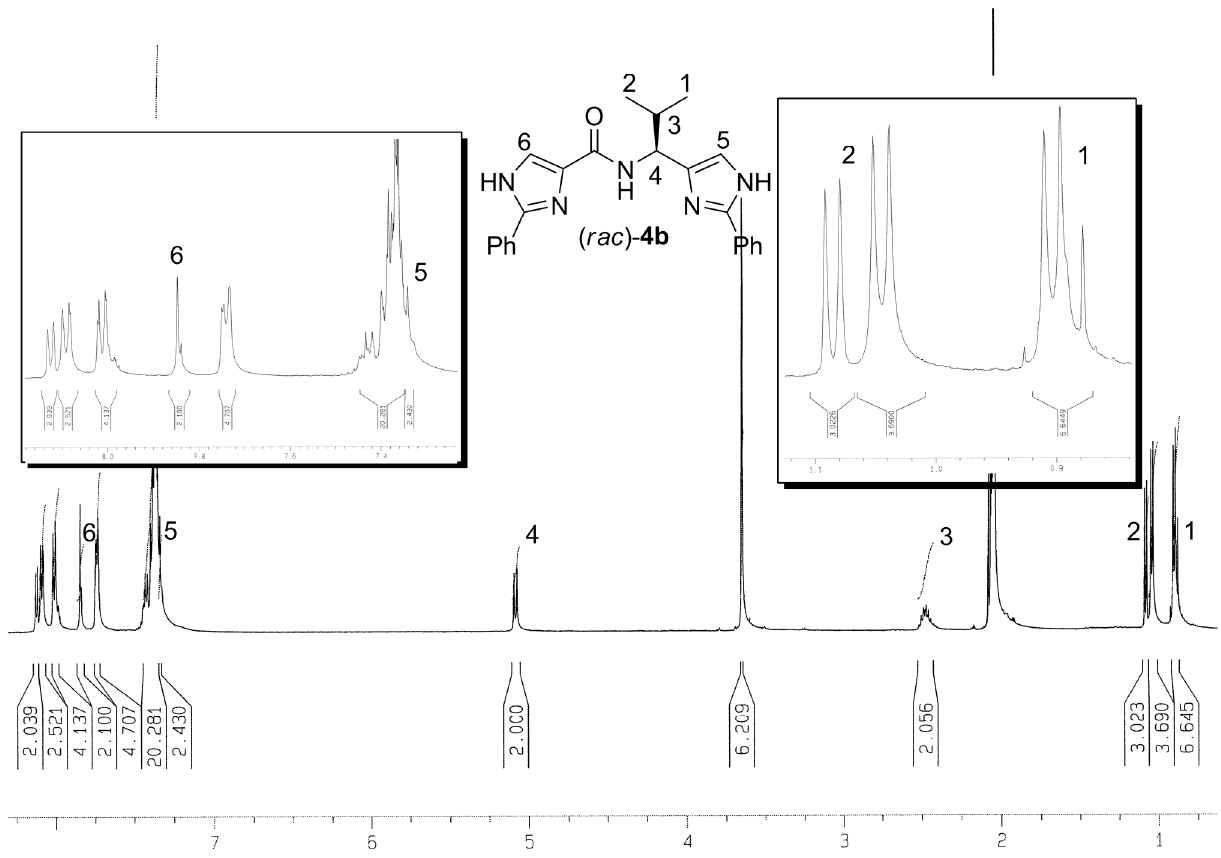
Figure 2. 1 H-NMR spectra of ( rac )- 4b measured with ( R )-Mosher’s acid ( d for the ee’s determination (compare in particular the 2-H signals with ( S )- 4b on the Figure